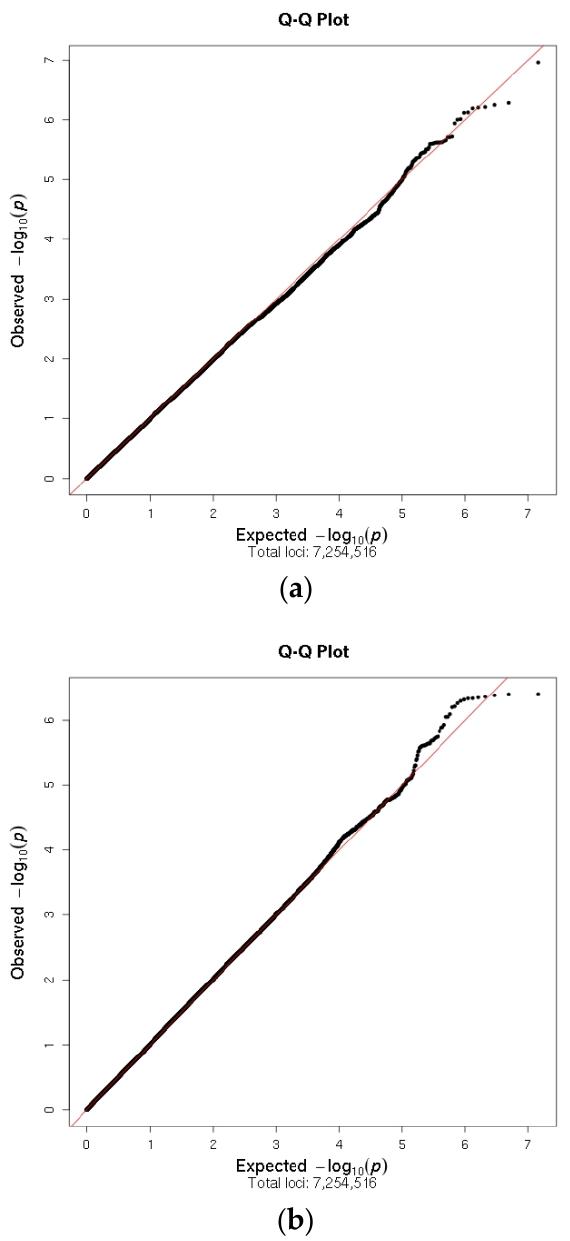
Figure 3. ( a ) Q-Q plot for genome-wide associations with PROMIS-10 global physical health in MCBDR cohort. ( b ) Q-Q plot for genome-wide associations with PROMIS-10 global physical health in MCBDR